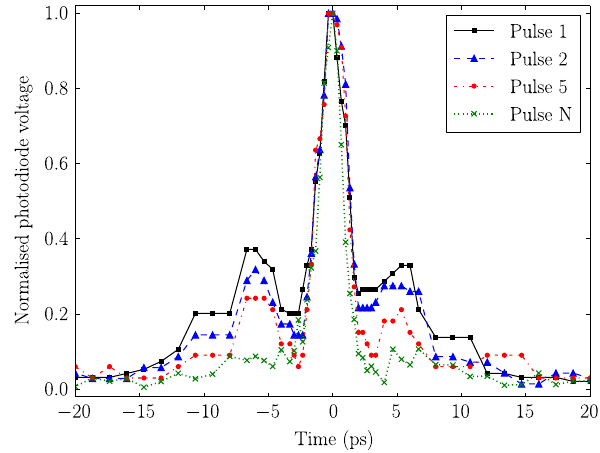
FIG. 14. Autocorrelation envelopes of pulses 1, 2, 5 and the n th pulse, which is a pulse much later in the burst that is in the steady state. Each is normalized showing a clear reduction in the wings as the pulse energy decreases.